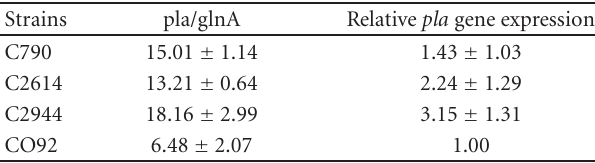
Table 1: Ratio of pla/glnA gene copy numbers determined by qPCR and pla gene expression by the Livak